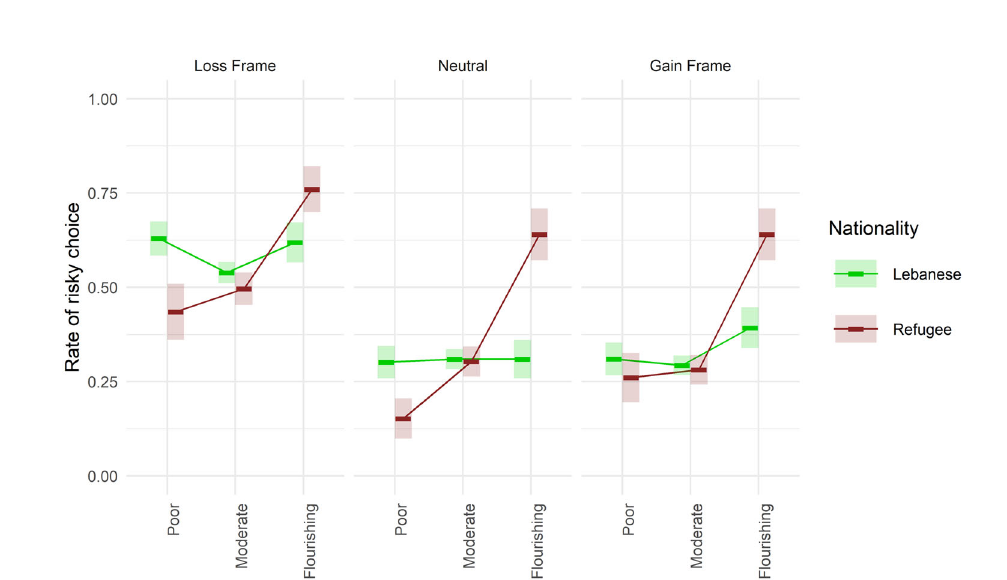
Fig. 6 Risk behaviour by subjective well-being. Thick lines represent group means. Shaded areas represent 95% bootstrapped con fi dence intervals.